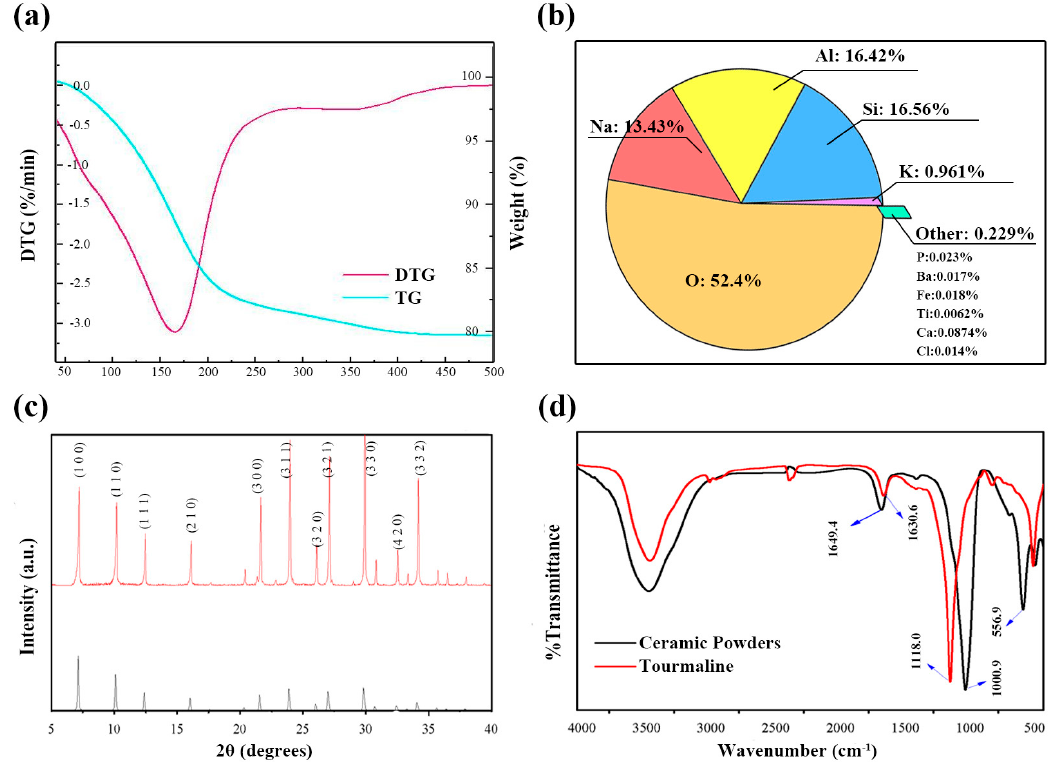
Figure 2. Mineralogical characterization of the ceramic powder: ( a ) TG and DTG curve; ( b ) major and minor elements (except for elements C and H); ( c ) XRD pattern; ( d ) FTIR spectra.